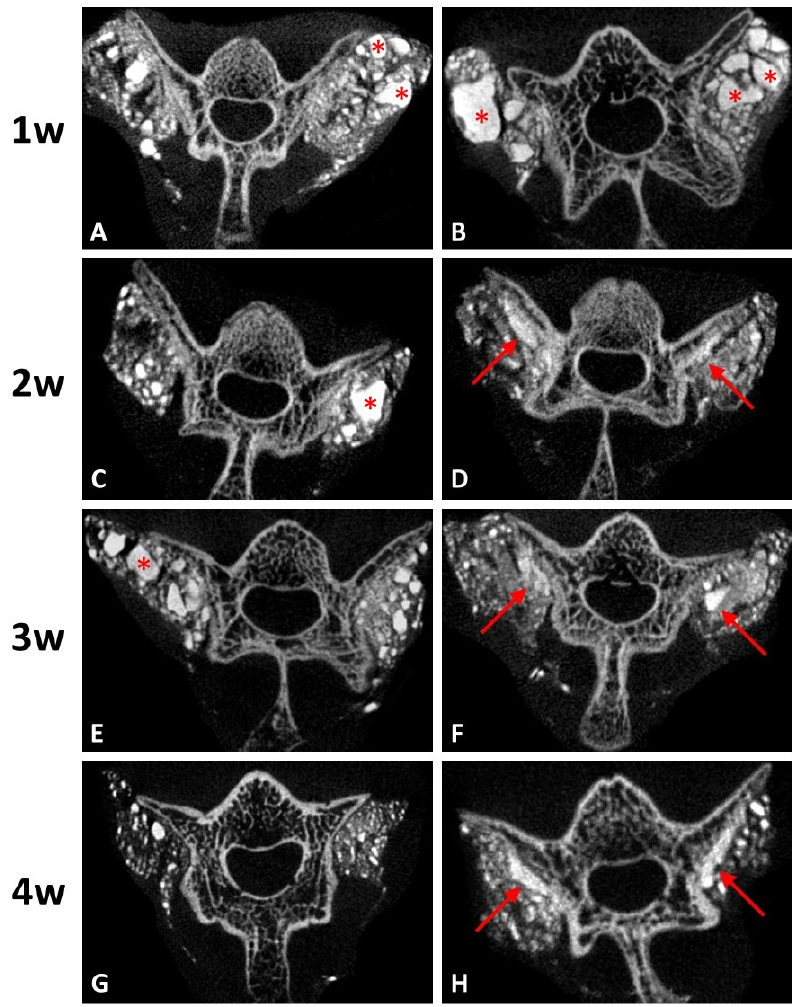
Figure 5. Coronal micro-CT images of the lumbar spines. ( A ), ( C ), ( E ), and ( G ) represent post- operative 1–4 weeks of DCP-rich CPC only, respectively. ( B ), ( D ), ( F ), and ( H ) represented post- operative 1–4 weeks of the DCP-rich CPC supplemented with 0.4 mL collagen, respectively. The star symbols indicate residual grafts and the arrows indicate callus formation. the arrows indicate callus formation. Materials 2017 , 10 , 910